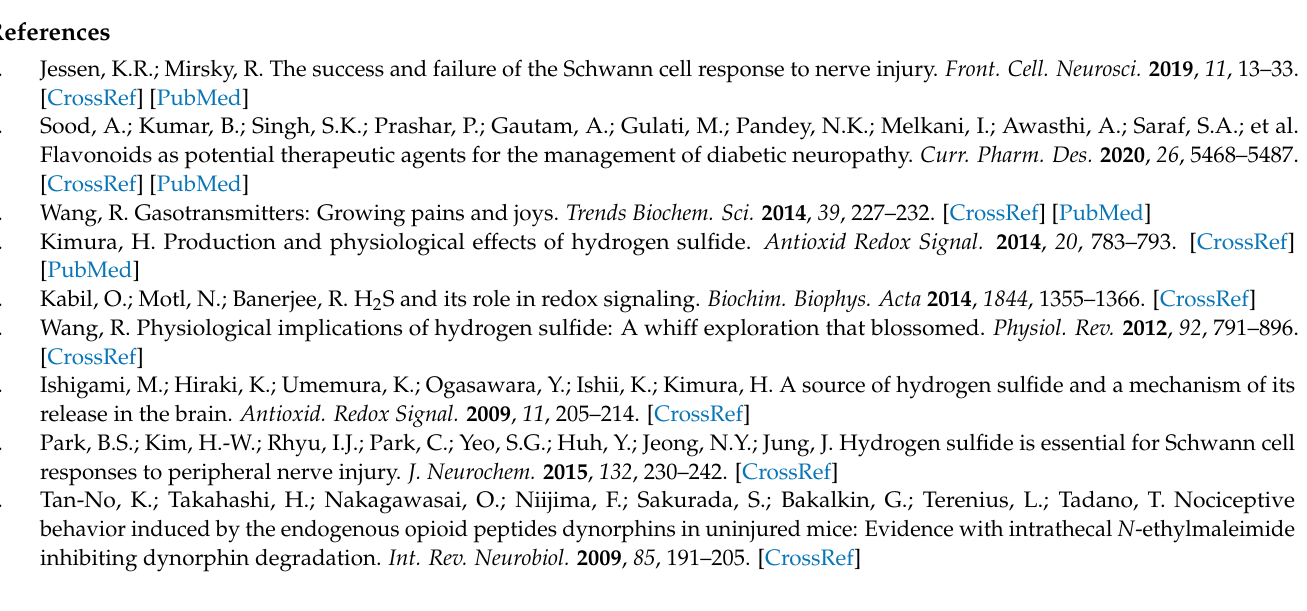
expression dynamic cluster 1–5 in global proteomics analysis among control, 1DIV, and NEM/1D; Figure S3: Kyoto Encyclopedia of Genes and Genomes (KEGG) and Protein Family (PFAM) using differentially expressed proteins (DEPs) between NEM/1D and 1DIV; Figure S4: Complexity be- tween the miRNAs and oxidative stress gene network; Figure S5; Interaction between miRNAs and transcription factor gene network; Table S1: List of primer sequences used for qPCR; Table S2: List of top 30 upregulated and downregulated genes; Table S3: List of oxidative stress and transcription factor genes; Table S4: List of top 30 upregulated and downregulated proteins; Table S5: List of top 30 upregulated and downregulated